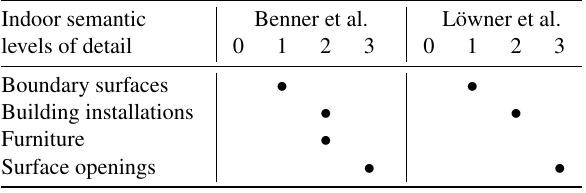
Figure 2. Indoor semantic levels of detail as proposed by